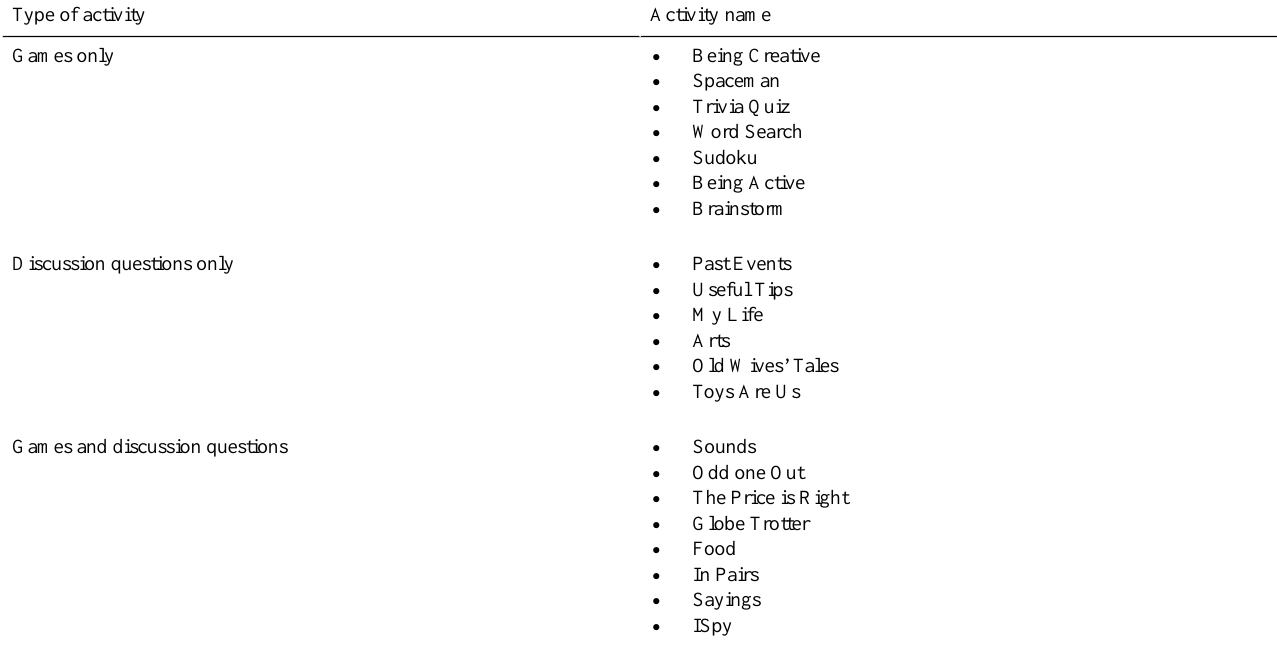
Table 1. List of the individual cognitive stimulation therapy app activities (prototype